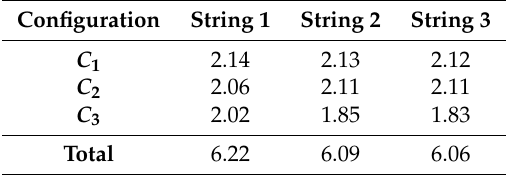
Table 3. Cell and string capacities (in (Ah) for Option 1) that maximizes total pack capacity.